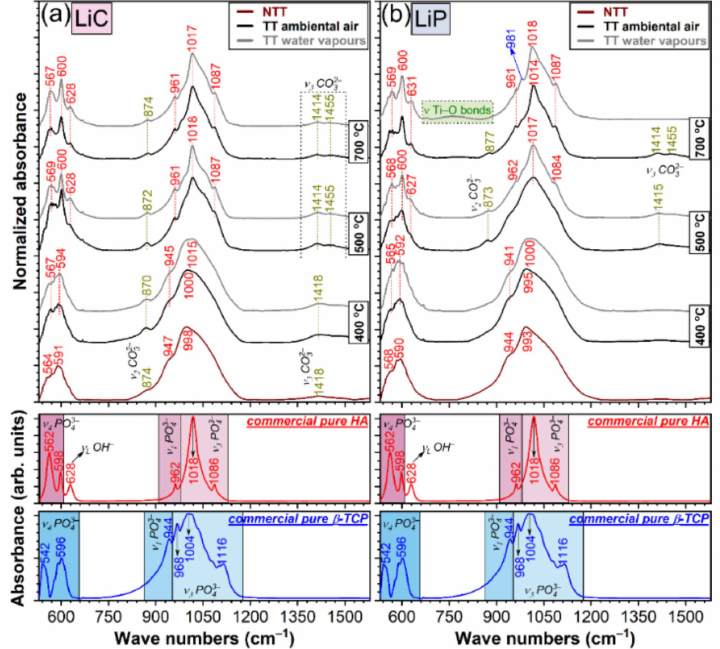
Figure 3. The FTIR-ATR spectra of the NTT and TT ( a ) LiC- and ( b ) LiP-type coatings, in air and water-vapor ambient. The reference spectra of pure (commercial) hydroxyapatite and β -tricalcium phosphate compounds are presented at the bottom of the graphs for